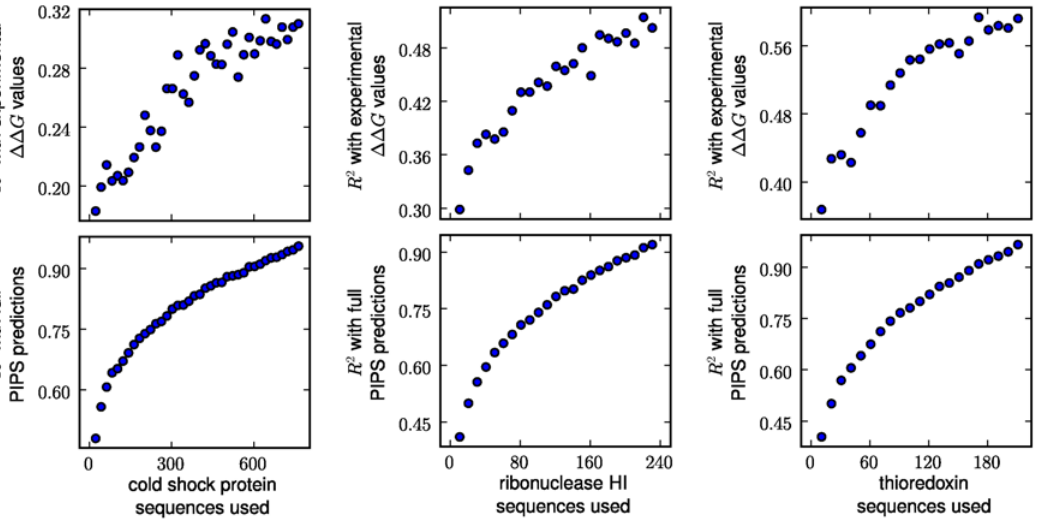
Figure 8. Performance of the phylogenetic inference approach as a function of the number of sequences used. The PIPS predictions using informative priors were run using subsets of all of the available protein sequences. The resulting DD G predictions were then correlated with the experimental DD G values (top) or the PIPS DD G predictions obtained using all available sequences (bottom). The R 2 values are the squared Pearson correlation coefficients. For each number of sequences used, the PIPS predictions were made using 10 different random sequence subsets, and the displayed R 2 values are the average correlations over these 10 subsets. For cold shock protein, the subsets were made at intervals of 20 sequences, while for ribonuclease HI and thioredoxin they were made at intervals of 10 sequences.